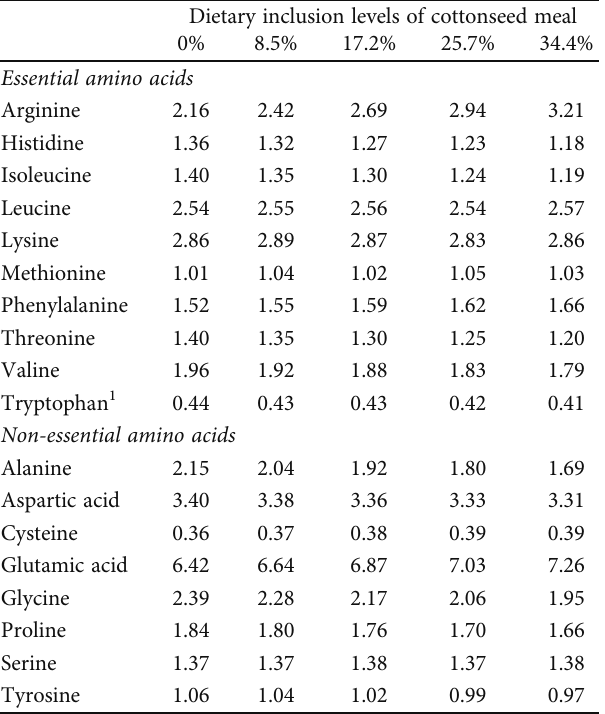
Table 2: Amino acid composition of the experiment diets (% dry